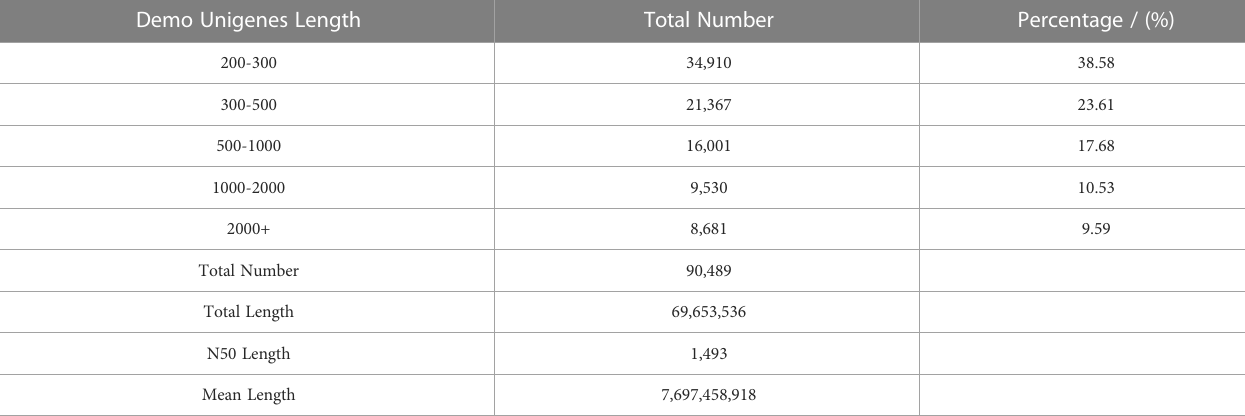
TABLE 3 Statistical table of assembly results.